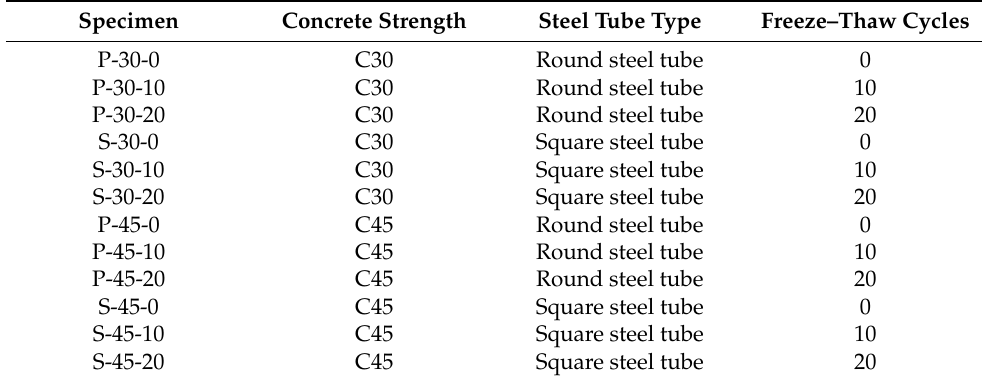
Figure 2. Concrete-filled steel tube push-out specimens. Table 3. Details regarding of push-out specimens.